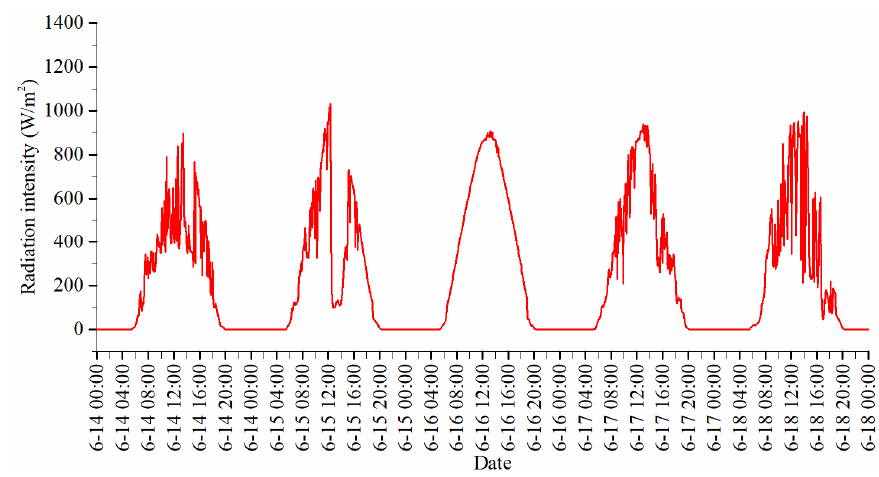
Figure 10. Selection of optimum days for summer illumination.